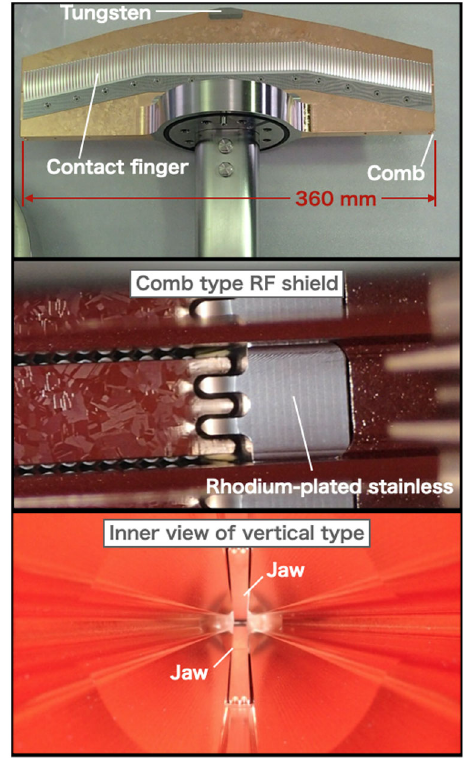
FIG. 4. Photograph of a jaw with rf shields.